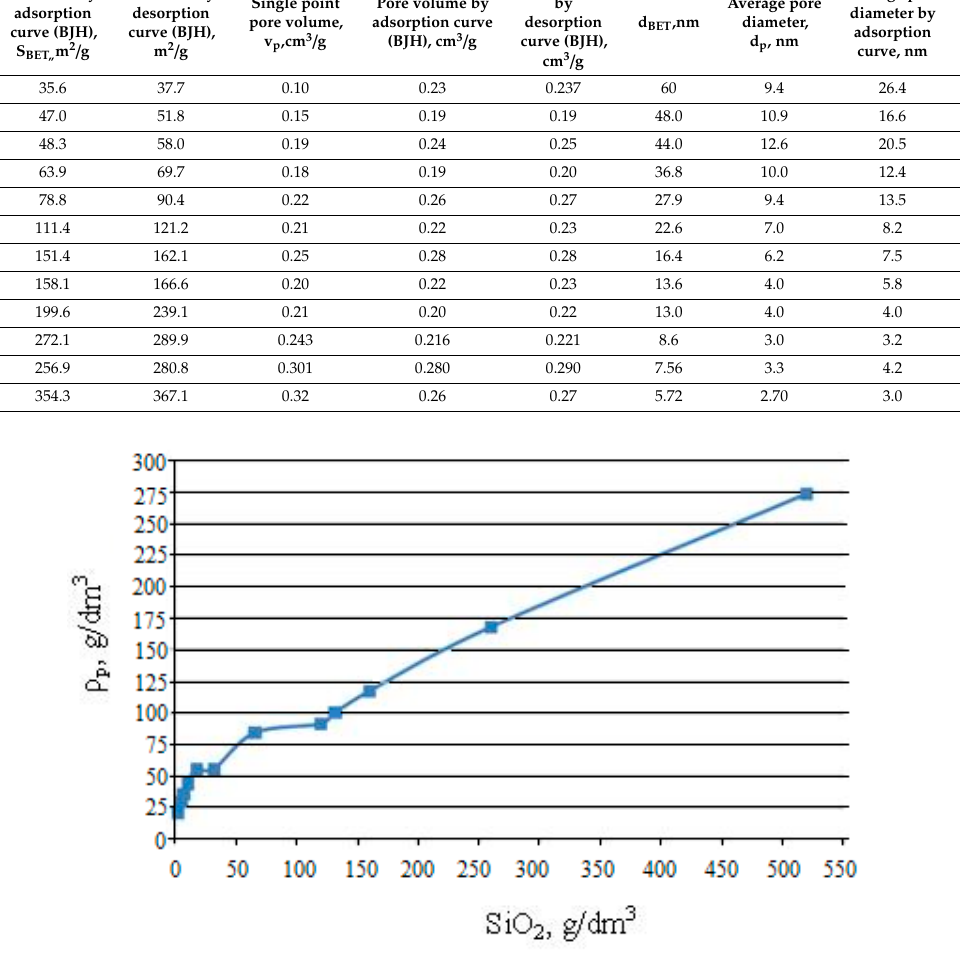
Figure 8. Dependence of the pour density of the nanopowder on the content of SiO 2 in the sol. 3.3. Pore Characteristics of Nanopowders Obtained by Cryochemical Vacuum Sublimation of SiO 2 Sols